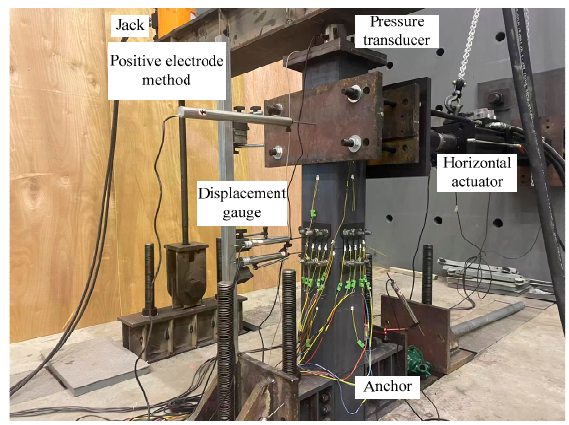
Figure 7. Measuring point arrangement.